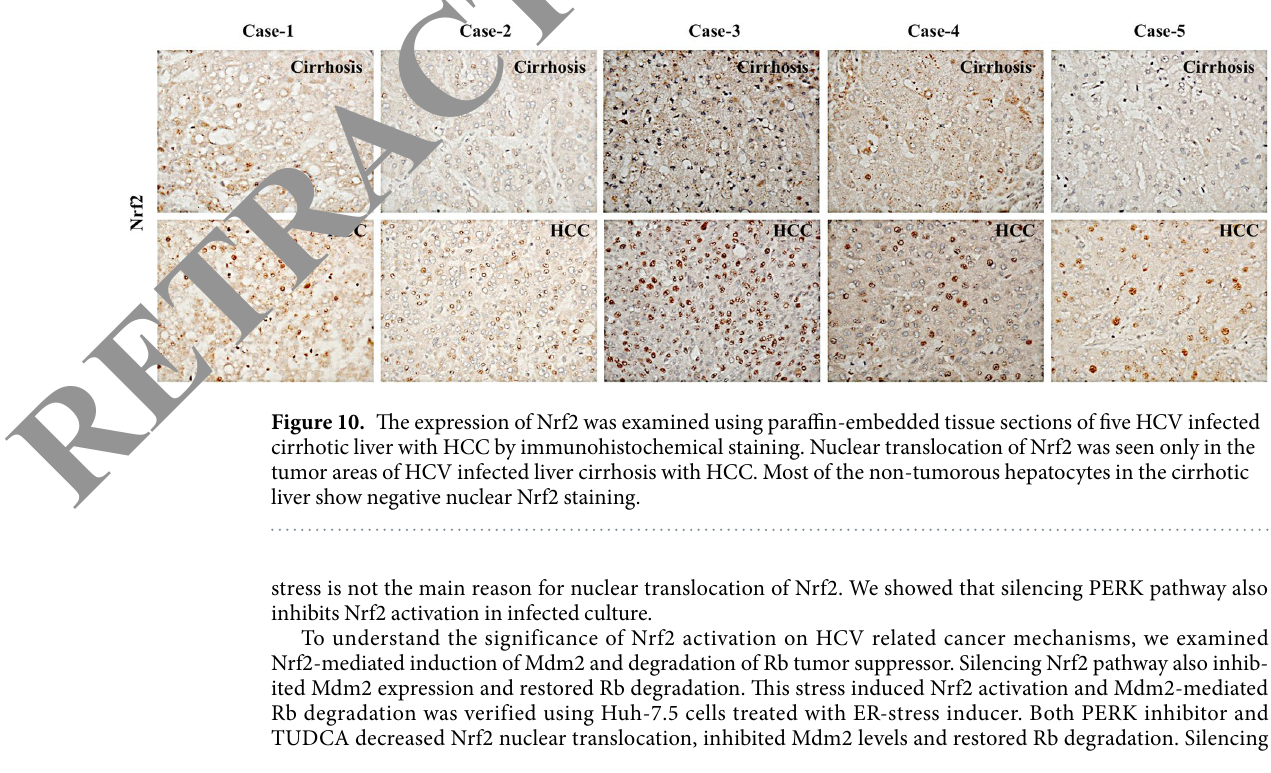
12 SCieNTifiC REPORtS | 7: 9223 | DOI:10.1038/s41598-017-10087-6